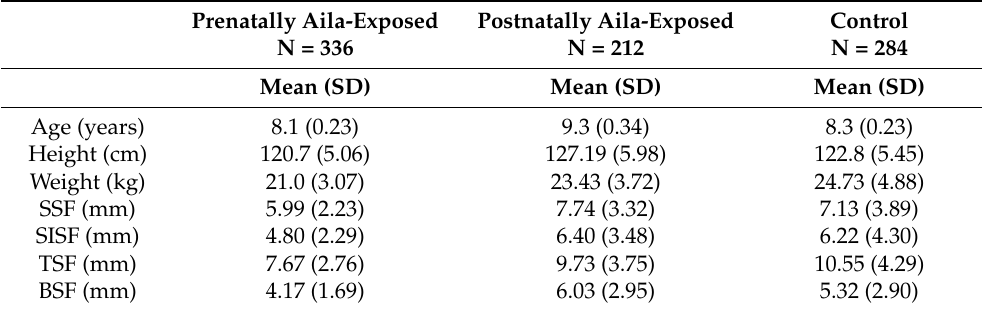
Table 1. Descriptive statistics of the anthropometric indices for the three study groups.